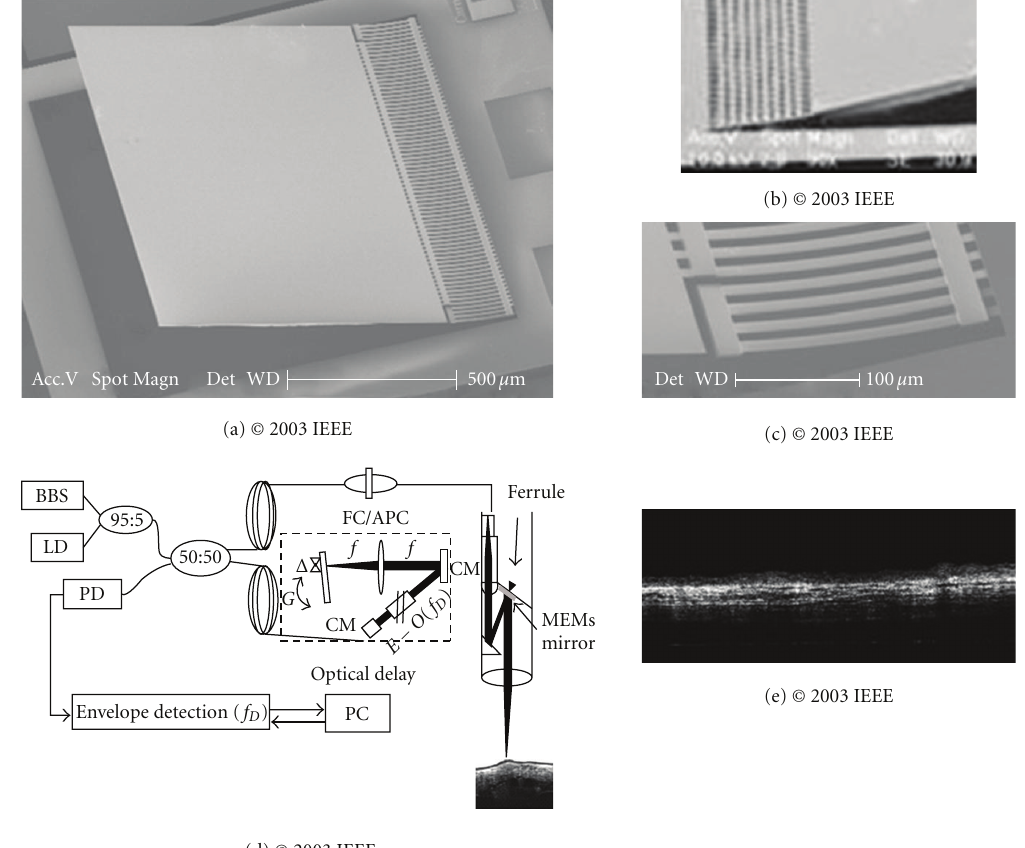
Figure 8: Electrothermal MEMS OCT reported by Pan et al. (a) SEM of 1D MEMS mirror, (b) meshed actuator structure, (c) parallel beam structure, (d) OCT system with forward looking endoscopic probe design, and (e) 2D OCT image of rabbit